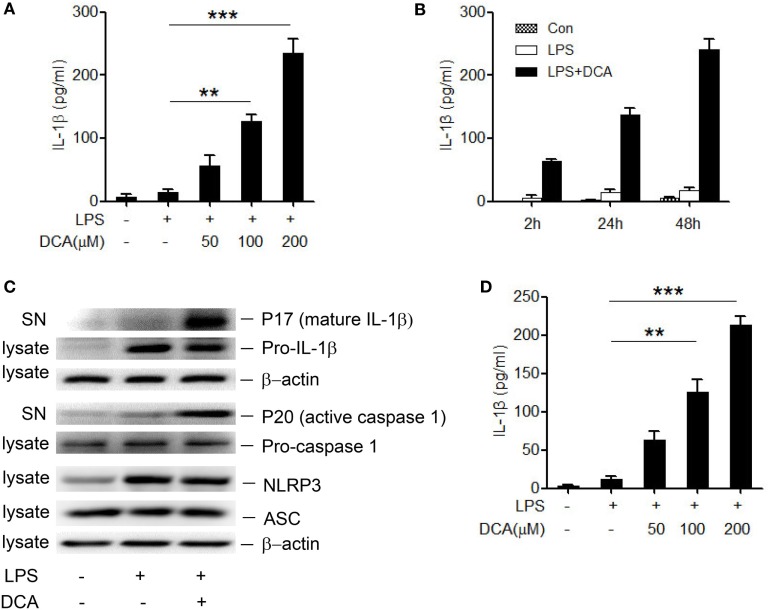
DCA induces mature IL-1β release from macrophages. (A) LPS-primed J774A.1 macrophages were treated with DCA (0, 50, 100, and 200 μM) for 24 h. Released IL-1β in culture medium was analyzed by ELISA. (B) LPS-primed J774A.1 macrophages were treated with DCA (100 μM) for different time courses. Released IL-1β was analyzed by ELISA. (C) Immunoblot analysis of mature IL-1β (mIL-1β, 17 kD), active caspase-1 (p20, 20 kD) in culture supernatants (SN) and precursors of IL-1β (pro-IL-1β), caspase-1 (pro-caspase-1), NLRP3, ASC in cell lysates of LPS-primed J774A.1 macrophages treated with DCA (100 μM) for 24 h. β-actin was regarded as a loading control. (D) ELISA analysis of IL-1β in supernatants from LPS-primed bone marrow-derived macrophages (BMDMs) treated with different dosage of DCA. **p < 0.01; ***p < 0.001. Error bars indicate SEM. Representative data from at least three independent experiments giving similar results are shown.